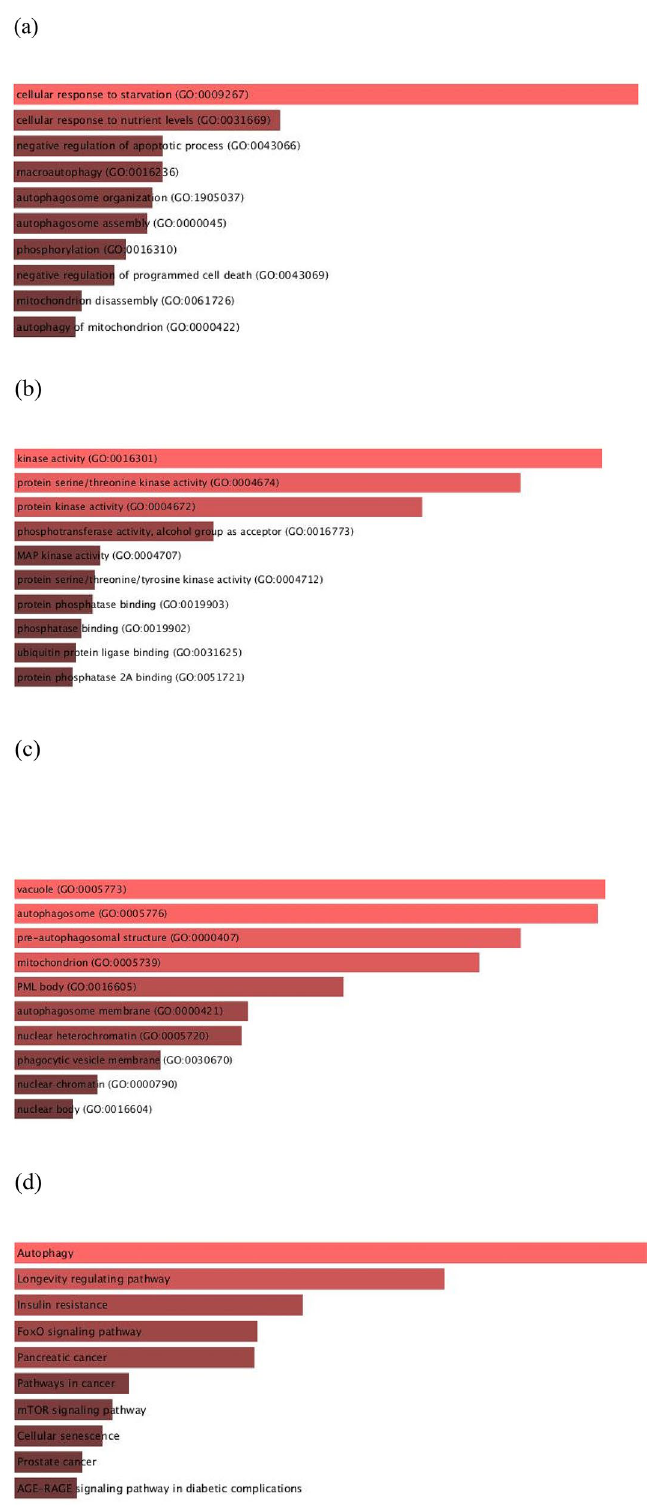
Figure 3. Gene ontology (GO) functional and Kyoto Encyclopedia of Genes and Genomes (KEGG) pathway enrichment analysis for the selected genes (performed via enricher). ( a ) GO Biological Process 2018; ( b ) GO Molecular Function 2018; ( c ) GO Cellular Component 2018; ( d ) KEGG